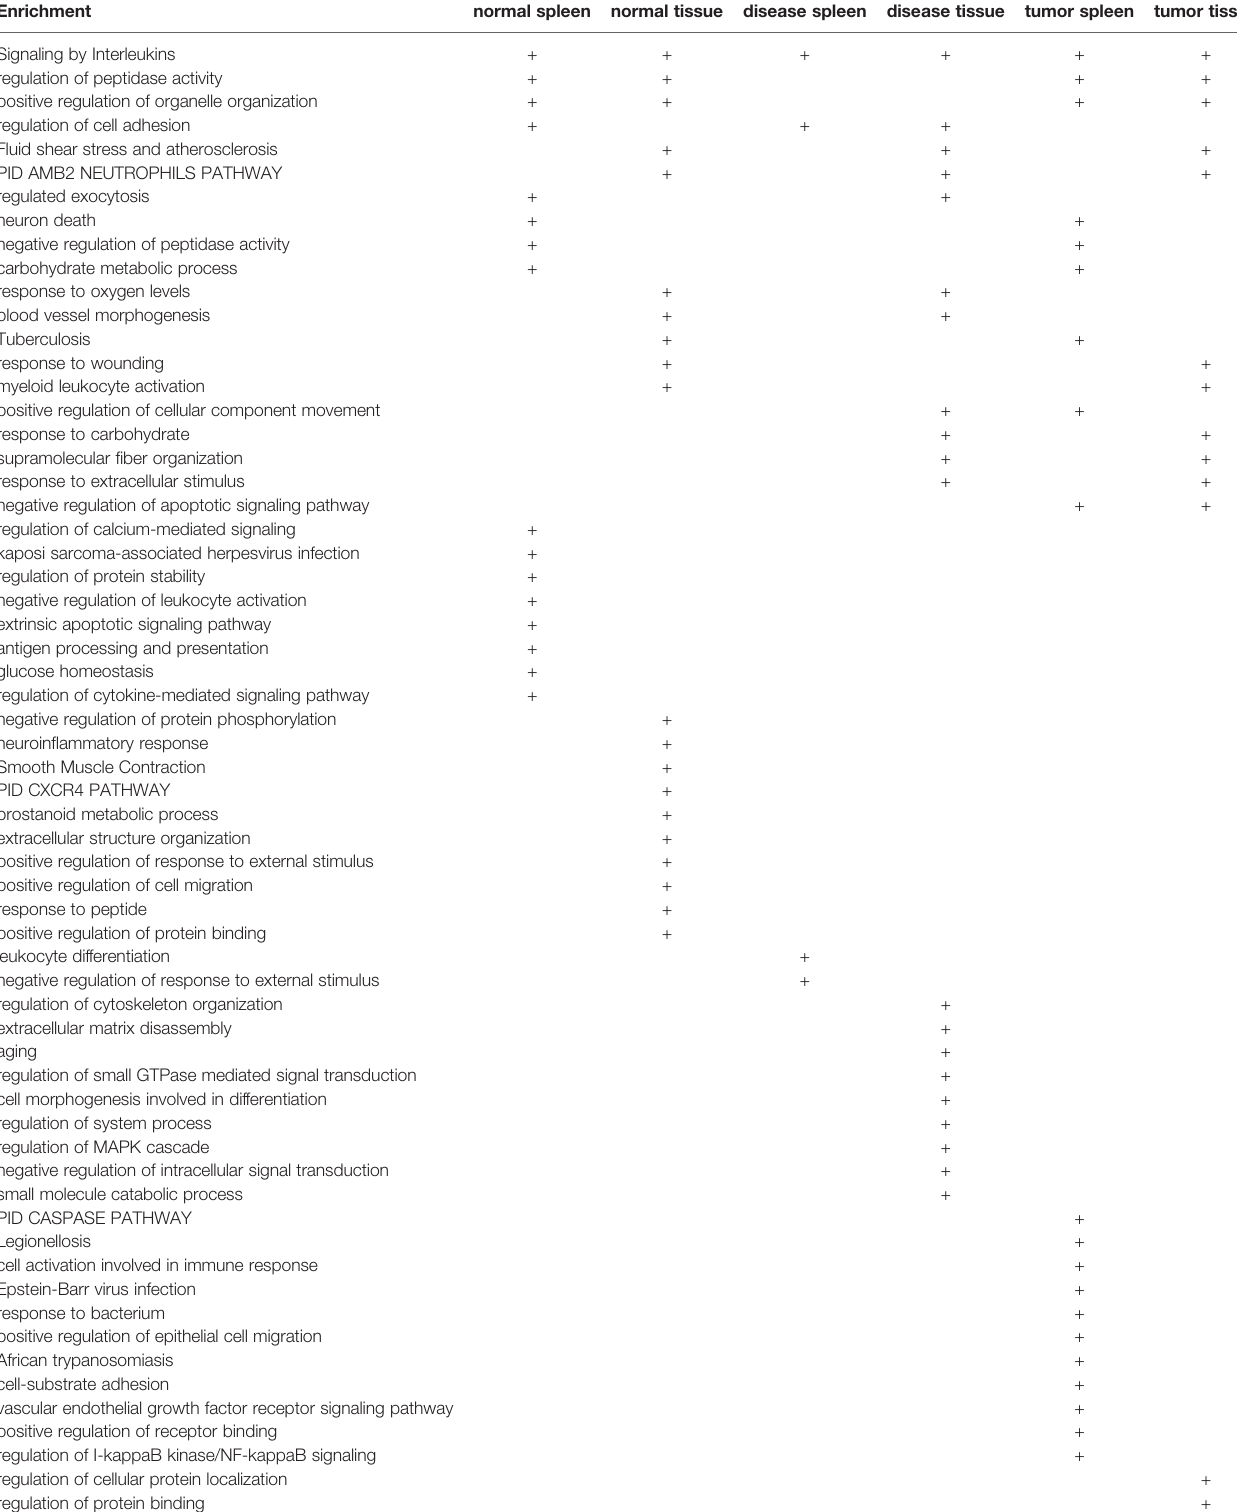
TABLE 3F | Metascape analysis was performed to identify pathways associated with upregulated caspase-4 dependent GSDMD secretome gene lists in various Treg groups. Enrichment Signaling by